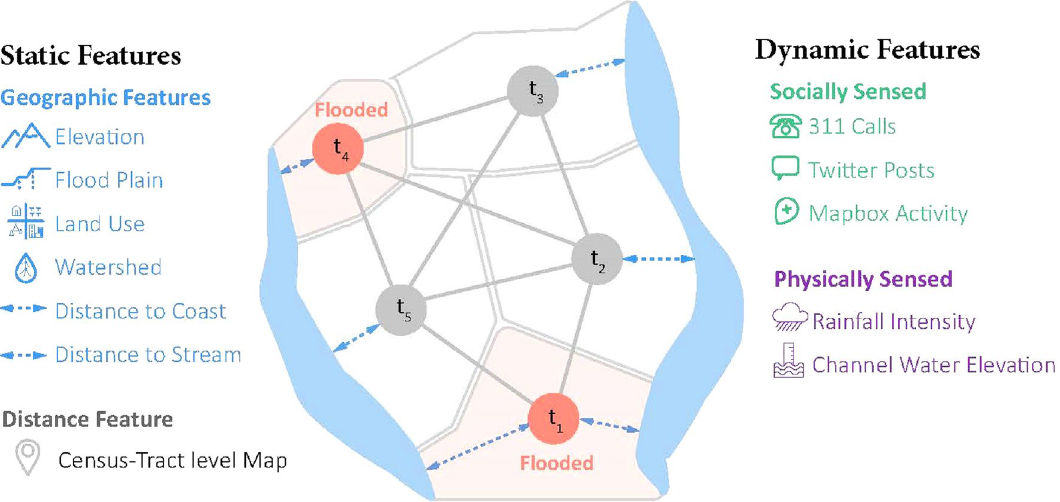
Figure 1. Schematic representation of the problem abstraction; the study area is modeled as a graph; static features and distance are used to determine weights, and physics-based and human-sensed dynamic features are used for predicting the extent of flooding.